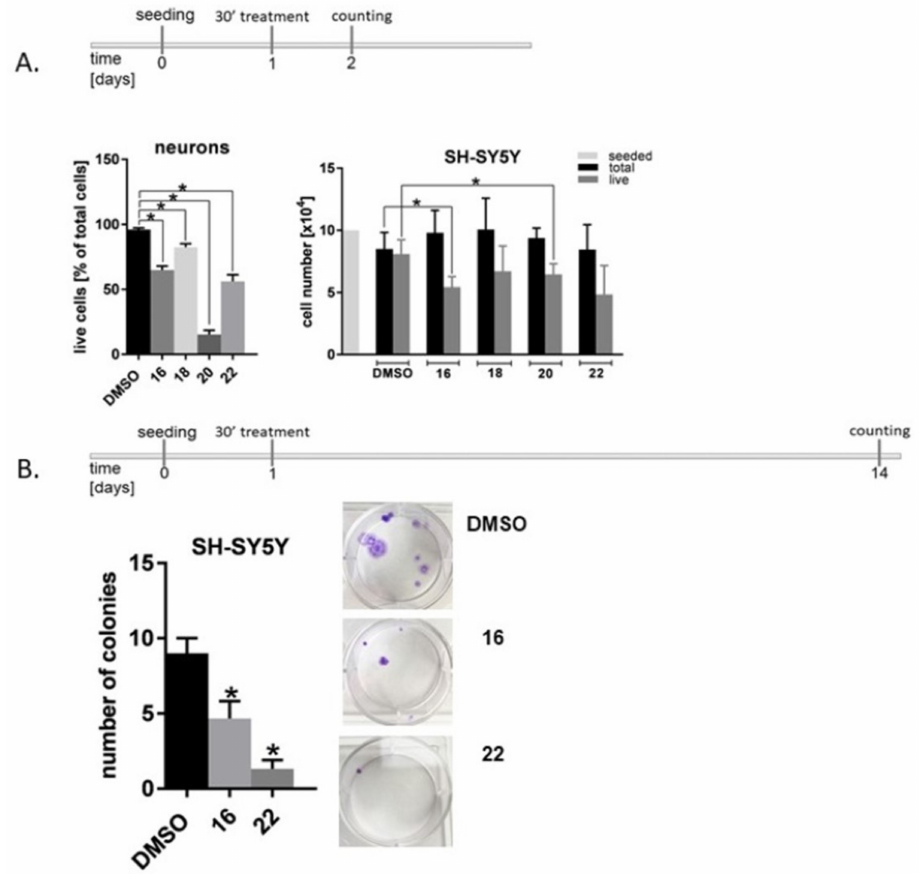
Figure 7. Susceptibility of rat neurons and human neuroblastoma cells SH-SY5Y to treatment with dendrimers. ( A ) Neurons and SH-SY5Y cells were treated either with 5 µ M dendrimers or DMSO according to a scheme presented in upper panel. Subsequently, the cells were counted and the results are shown in lower panel. * p < 0.05 ( T -test). ( B ) SH-SY5Y cells were treated either with 5 µ M dendrimers ( 16 or 22 ) or DMSO according to a scheme presented in upper panel. Subsequently, the colonies were counted and the results, together with representative pictures, are shown in the lower panel. * p < 0.05 vs. DMSO-treated cells ( T